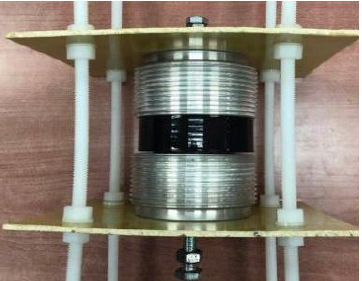
1. Table 1. Size and parameters of test sample of zinc oxide valve plate. Table 1. Size and parameters of test sample of zinc oxide valve plate.